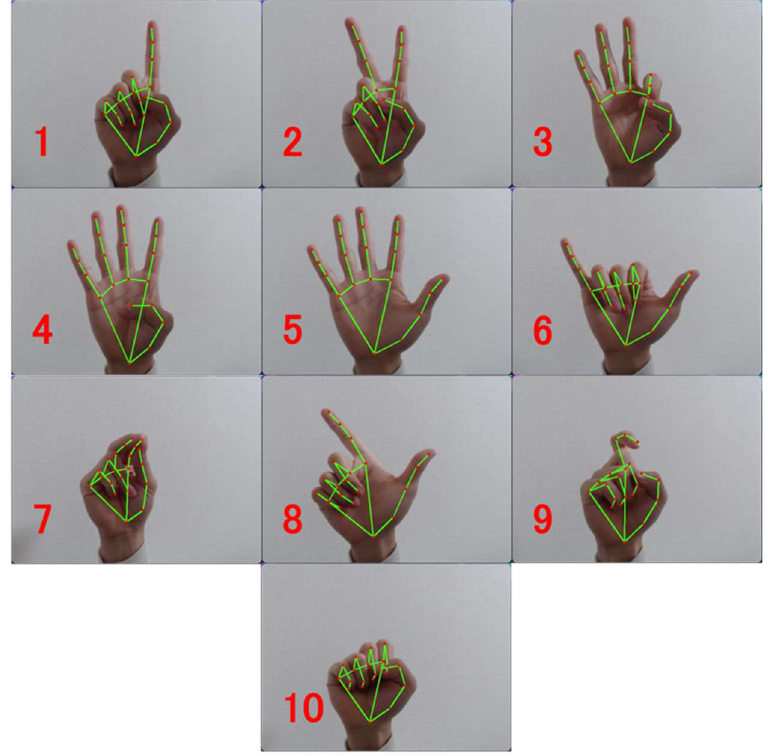
Figure 3. Example of a Chinese counting gesture. The meaning of each gesture is shown in red.